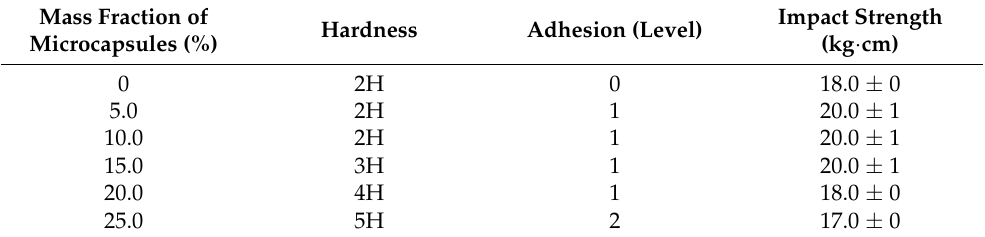
Table 10. Mechanical properties of coating with different microcapsules content.